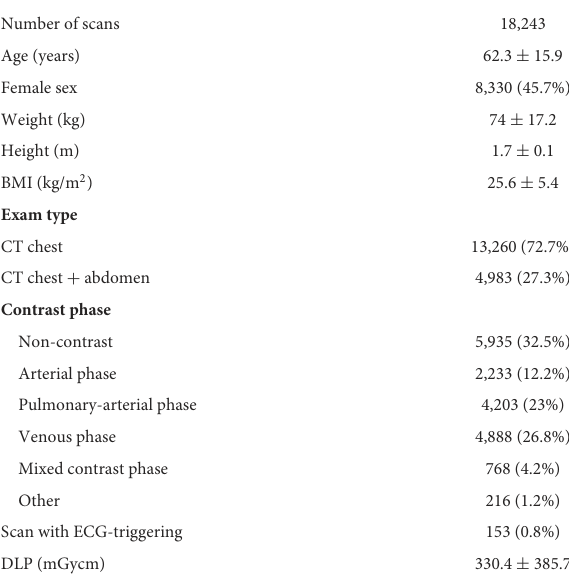
TABLE 1 Baseline characteristics for the entire